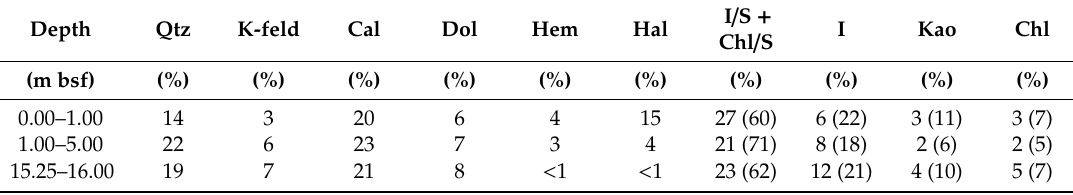
Figure 6. ( a ) Liquidity index profile along the A3 borehole; ( b ) photographs of the samples at different coring depths. Table 4. Mineralogical composition (weight %) of the bulk sample and in the clay fraction (in parentheses) of the submarine sediments from borehole A3. Key: Qtz, quartz; K-feld, feldspars; Cal, calcite; Dol, dolomite; Hem, hematite; Hal, halite; I / S, illite / smectite; Chl / S, chlorite / smectite; I, illite; Kao, kaolinite; Chl, chlorite